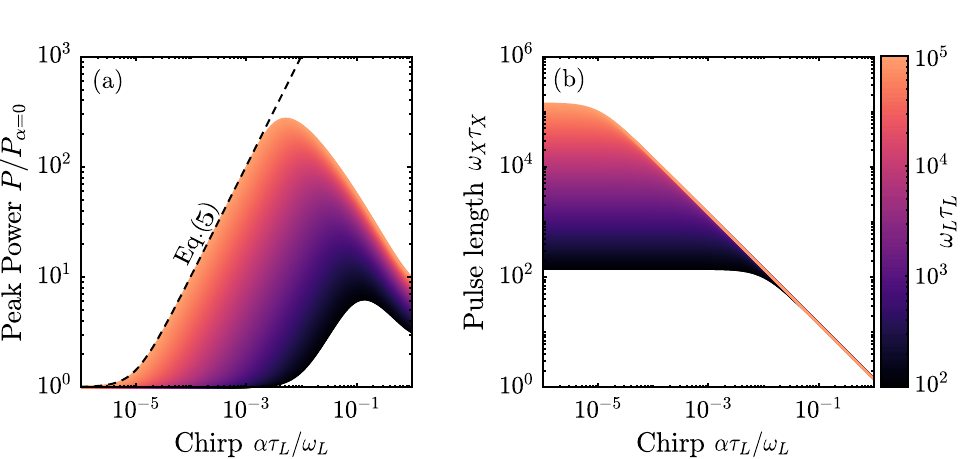
Figure 3. ( a ) Peak power P with respect to monochromatic peak power P α 0 plotted against relative rms = 0 ) as calculated analytically (dashed line) frequency chirp ατ L /ω L for an ideal on-axis matched CEM ( σ ⊥ = and by numerical integration of Eq. (28) for different laser pulse length (colors). The electron mirror is GDD τ min . ( b ) Normalized pulse length ω X τ X as function of relative rms frequency chirp for matched with τ CEM = different laser pulse length